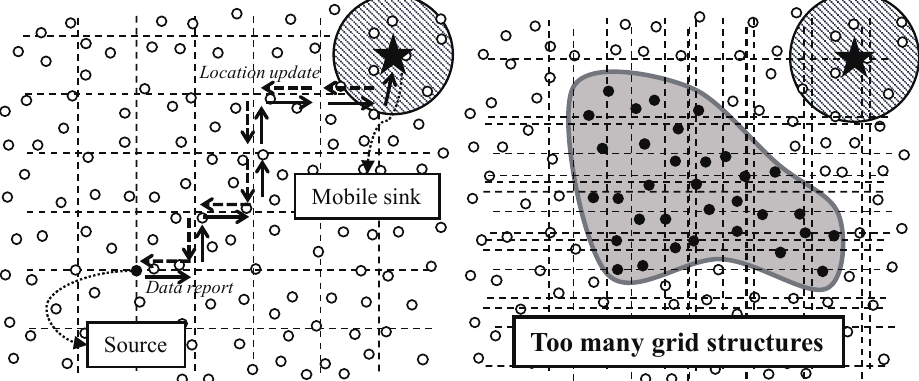
Figure 5. Examples of object tracking in TTDD: ( left ) Individual object tracking and ( right ) continuous object